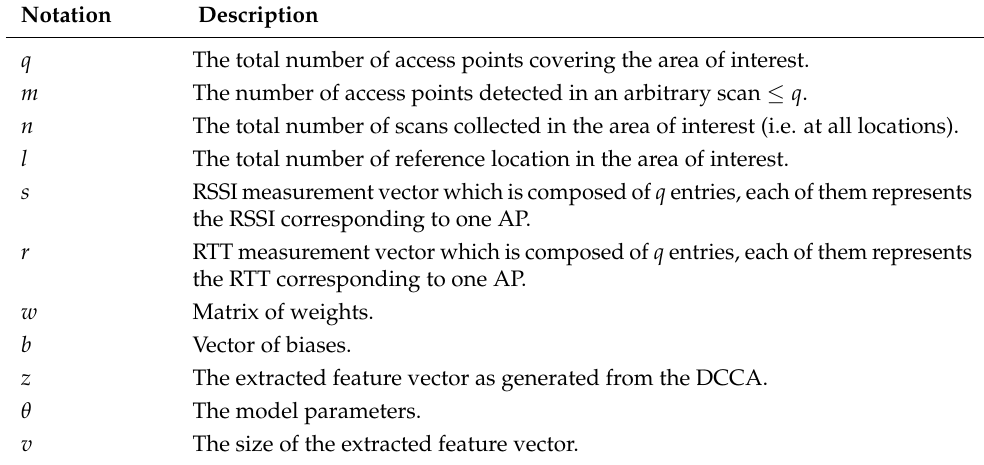
Table 1. Notations used in the